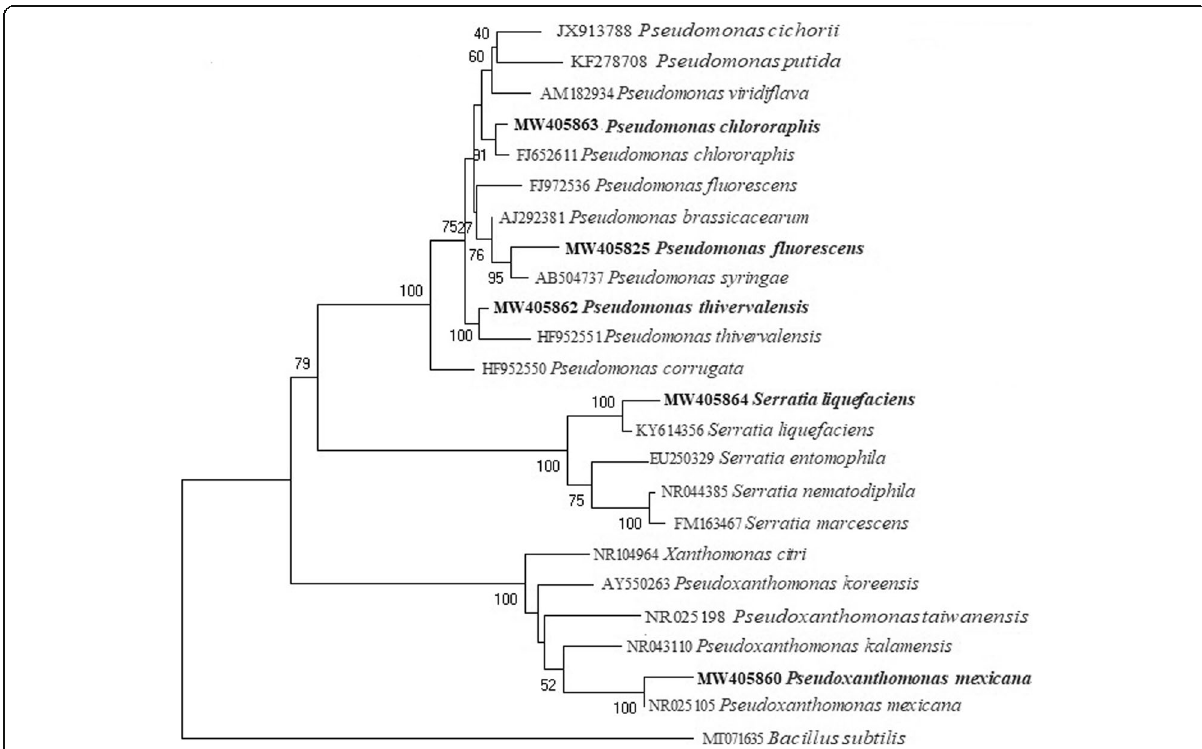
Fig. 3 Phylogenetic tree of five gram negative bacterial isolates, generated by the neighbor-joining method. The bold names are related to isolates: (10). Pseudomonas chlororaphis (MW405863), (11). P . fluorescens (MW405825), (5). P . thivervalensis (MW405862), (7). Serratia liquefaciens (MW405864) and (2), Pseudoxantomonas Mexicana